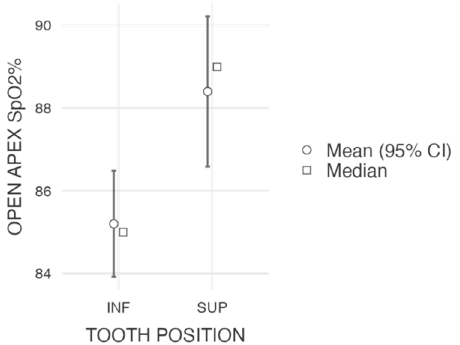
Figure 7. Graphic representation of SpO 2 measured in primary superior (SUP) vs. inferior (INF) canines with an open apex. Table 5. Pairwise comparisons between superior and inferior permanent teeth by tooth type.